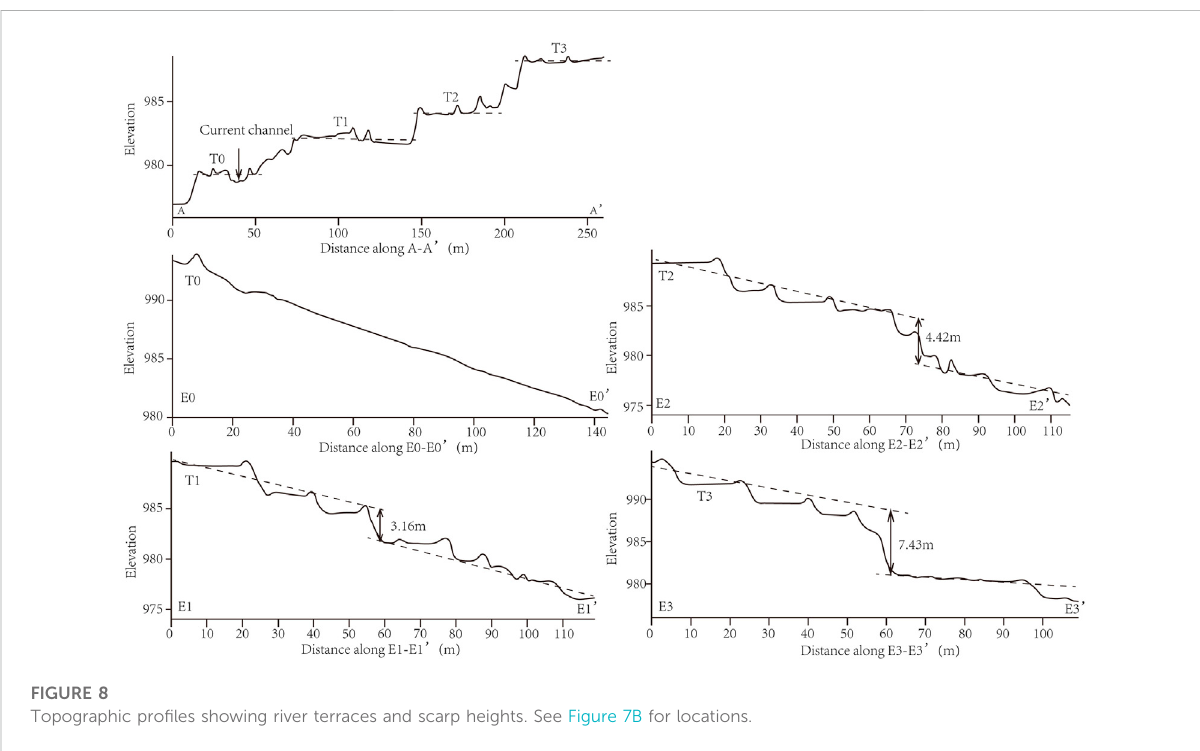
FIGURE 8 Topographic pro fi les showing river terraces and scarp heights. See Figure 7B for locations.